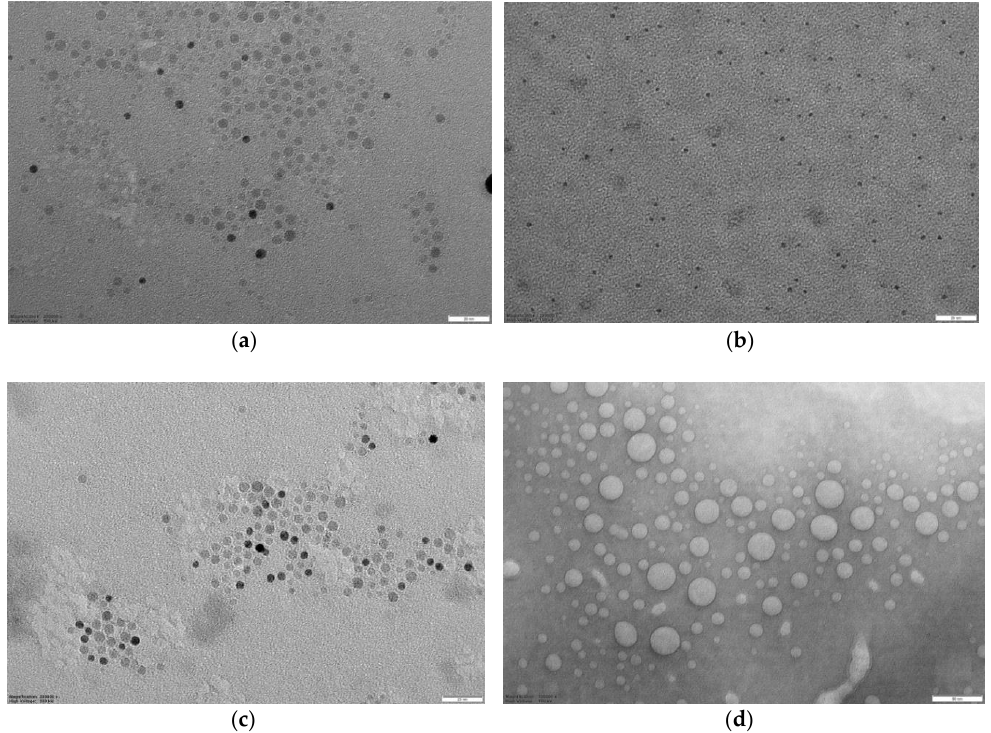
Figure 3. TEM images; ( a ) MIP 4VP-TY (200,000×, bar 20 nm); ( b ) MIP 4VP-HT (200,000×, bar 20 nm); ( c ) MIP 13-TY (200,000×, bar 20 nm); ( d ) MIP 13-HT (100,000×, bar 50